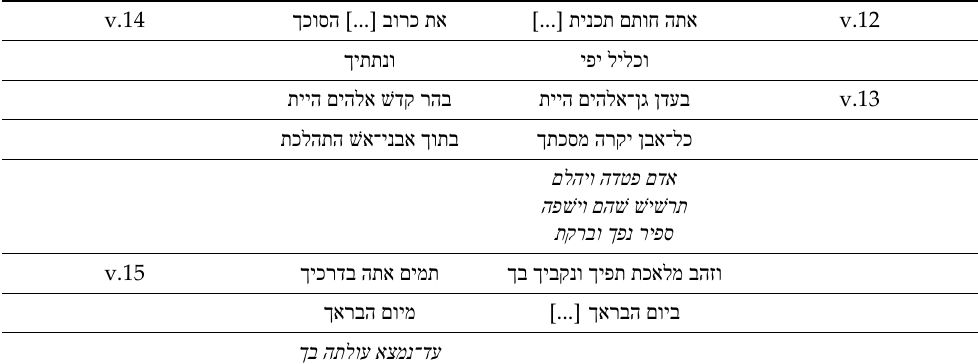
Table 1. The Reconstructed Parent Text of MT Ezekiel